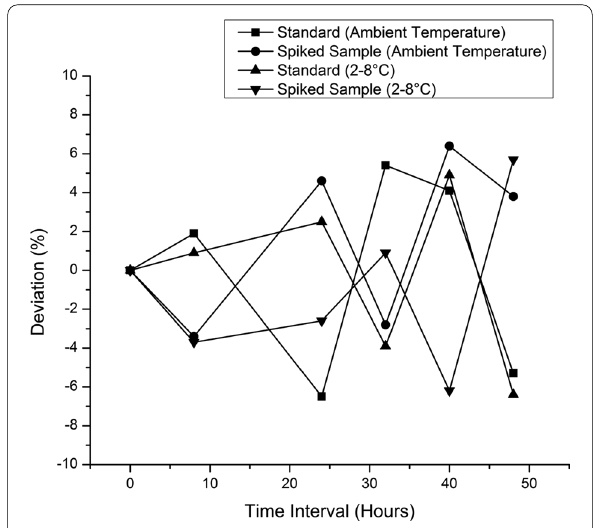
Fig. 4 Overlay of stability data of EMS in standard and spiked sample at ambient laboratory and refrigerated (2–8 °C)